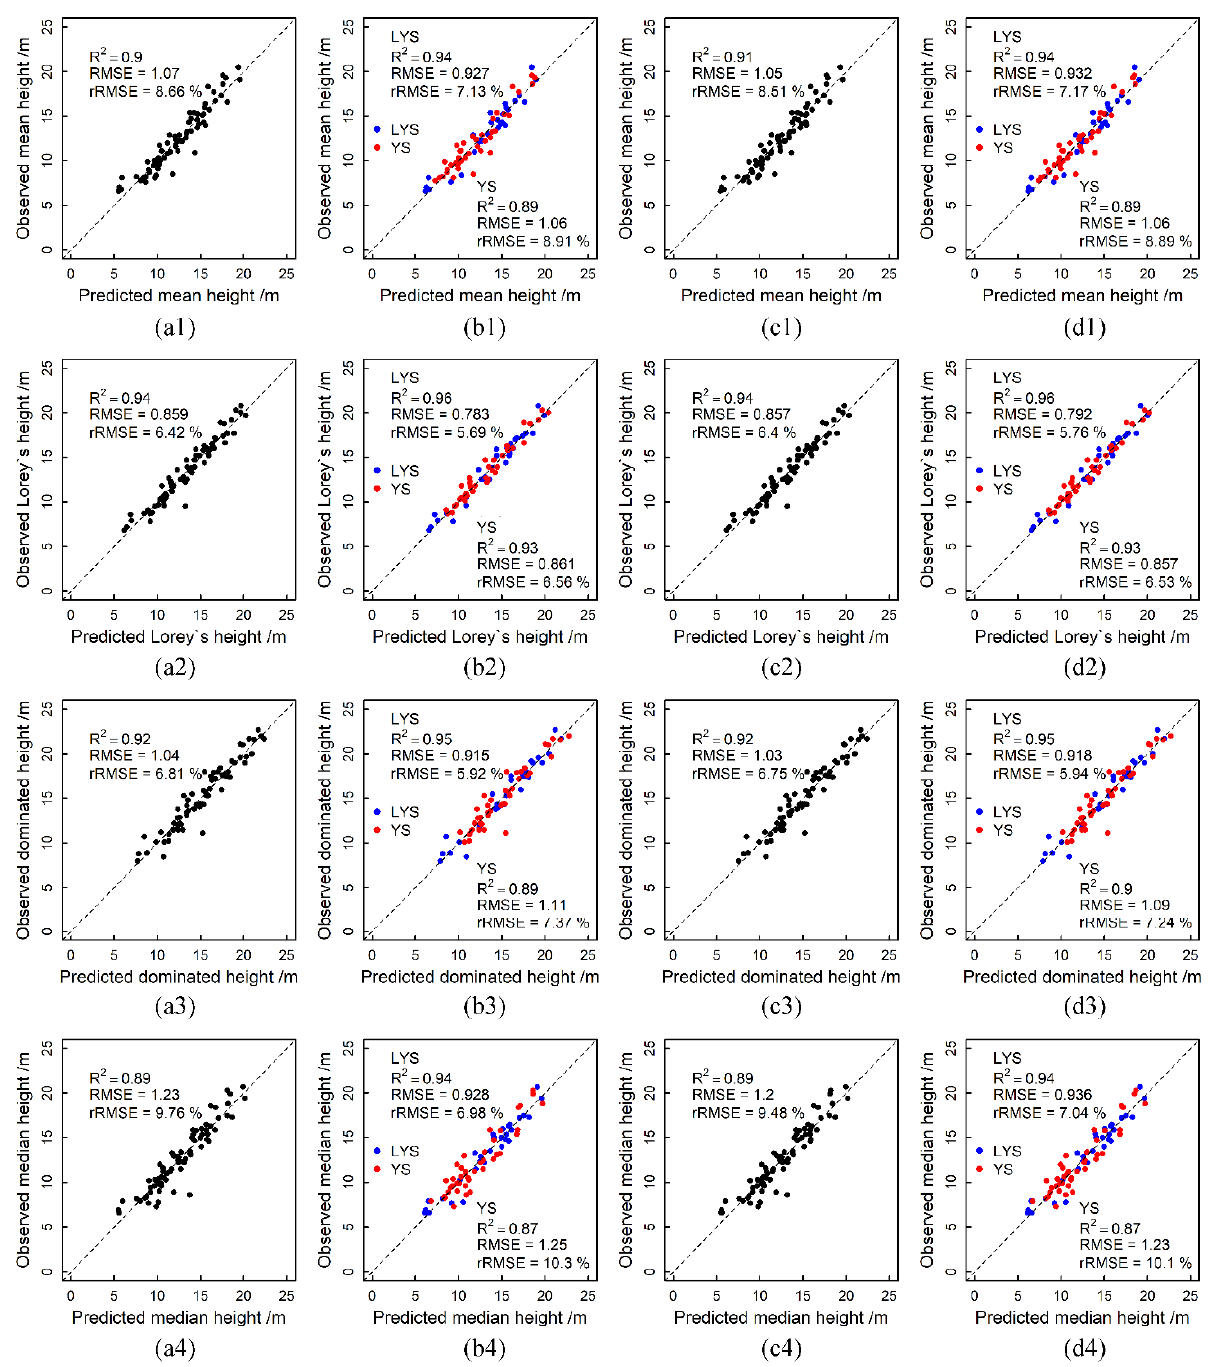
Figure 11. The scatterplot of estimated forest stand height and field measured height using USP metrics. ( a1 – a4 , b1 – b4 ) for P-NPC. ( c1 – c4 , d1 – d4 ) for P-CHM.